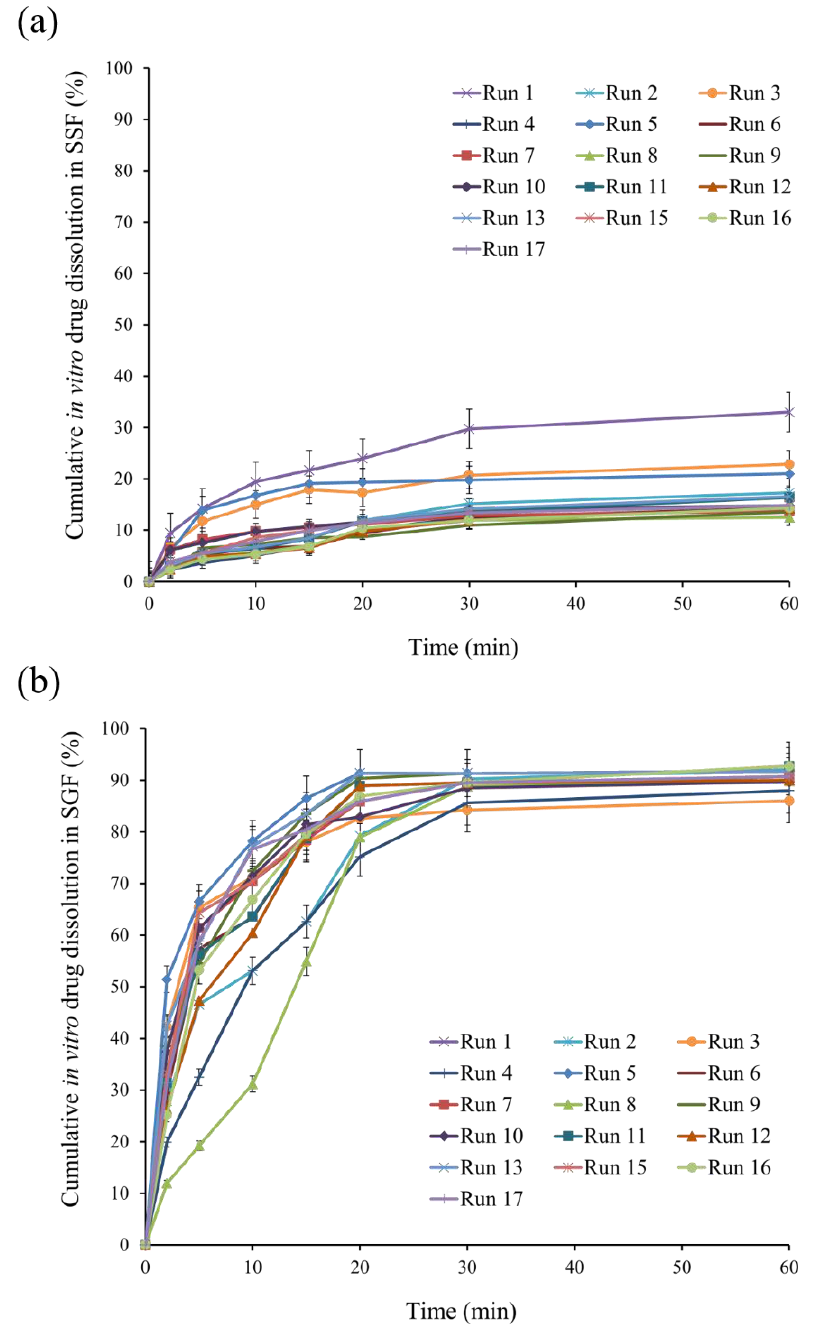
Figure 4. In vitro drug dissolution profiles of standard runs in ( a ) SSF and ( b ) SGF.